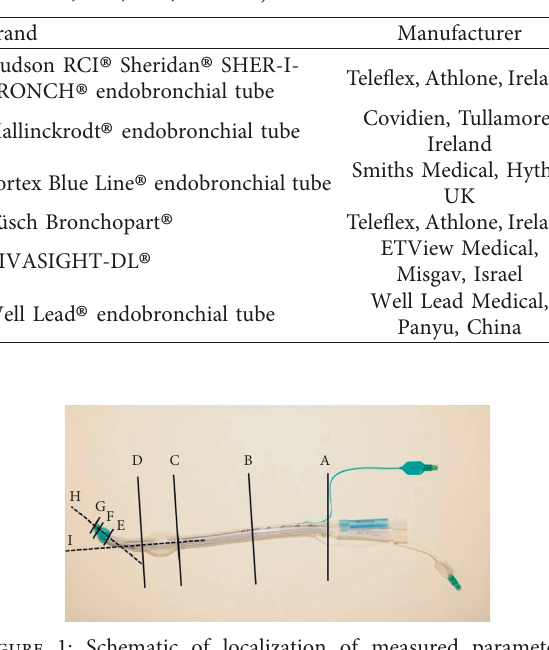
Table 1: Investigated left-sided double-lumen endobronchial tubes (sizes 35F, 37 F, 39F, and